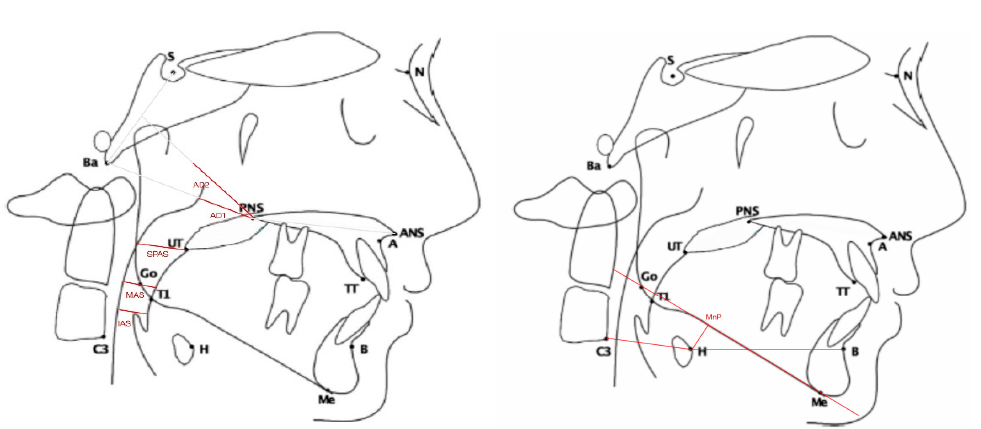
Figure 1. Representation of the cephalometric landmarks and references lines used for the airway space and hyoid bone measurements (sketches courtesy of Dr. Sara Ghanim) (S – point Sella; N – point Nasion; A – point A; ANS – anterior nasal spine; UT – tip of the uvula ; T1 – tongue base ; TT – tip of the tongue).